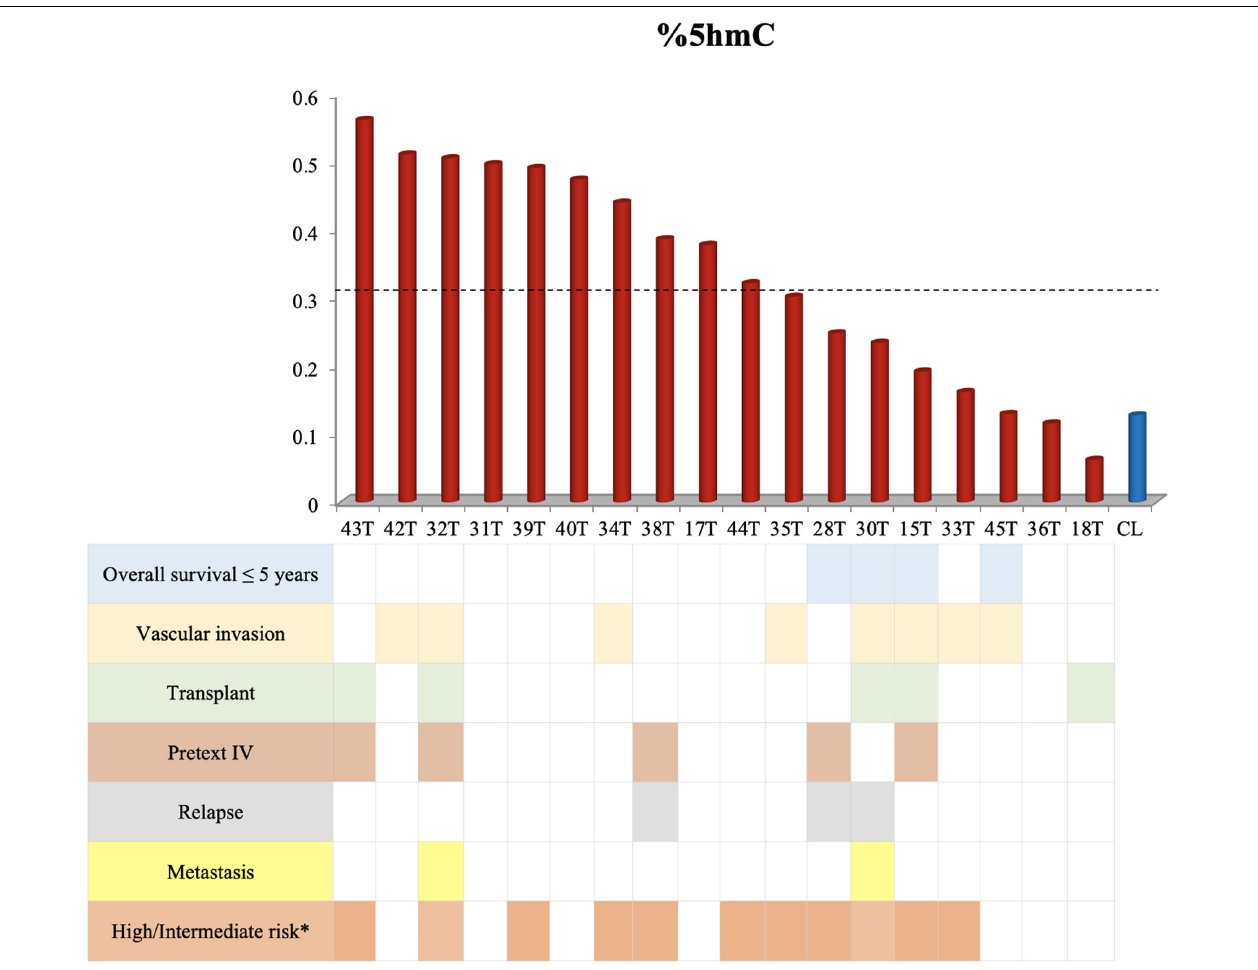
FIGURE 3 | Decreased overall survival is associated with lower levels of 5hmC. This figure shows the 5hmC global content of 18 tumor samples in the columns and their respective clinical data below. Tumor samples with overall survival ≤ 5 years present reduced 5hmC content, below the mean of the tumor group (0.33% - represented by the dashed line) and close to the level of non-tumoral hepatic tissues (CL). The Fisher’s test was used for the statistical analysis. p -value 0.02. CL: non-tumoral liver tissue samples; T: hepatoblastoma tumor samples. ∗ According to the CHIC criteria (Meyers et al.,